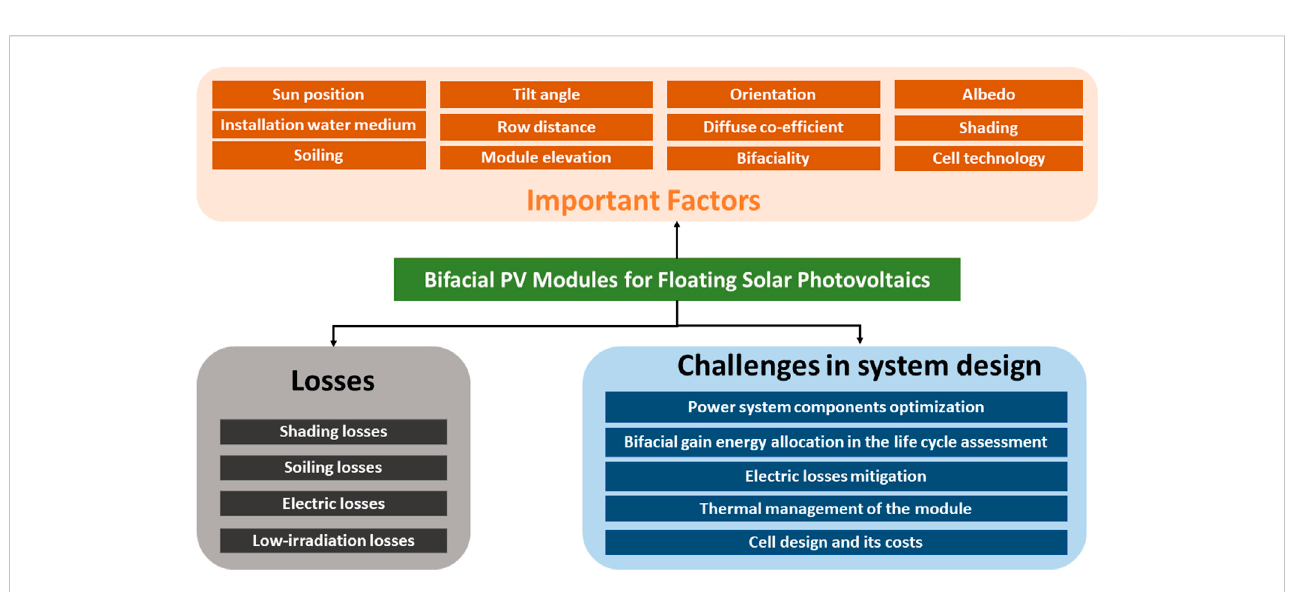
FIGURE 3 Different important factors, losses, and signi fi cant challenges of bifacial PV systems.